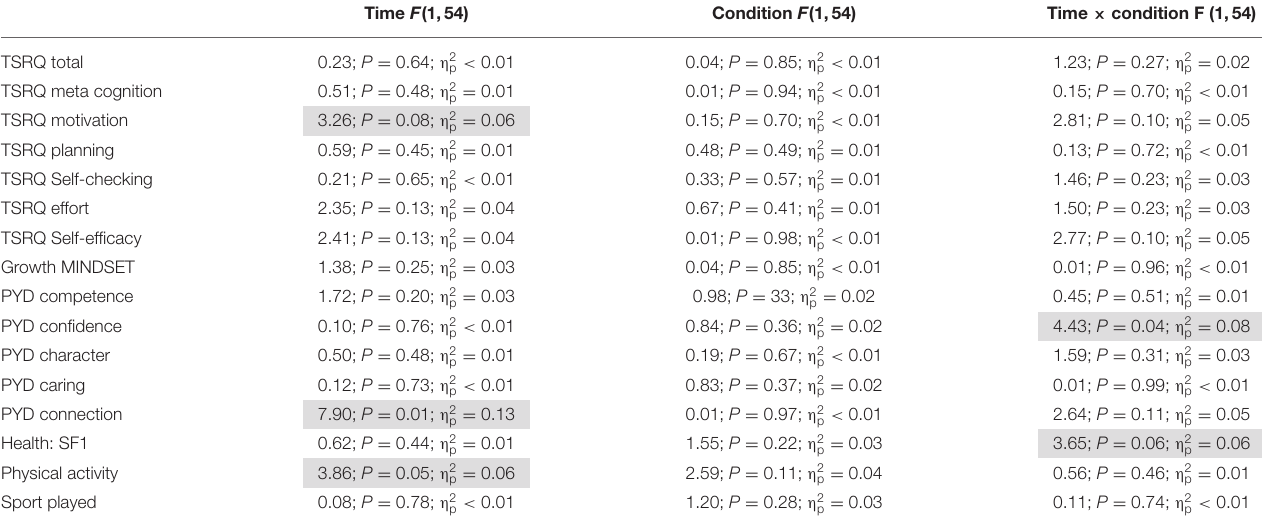
TABLE 3 | Results of the repeated measures analysis of variance.